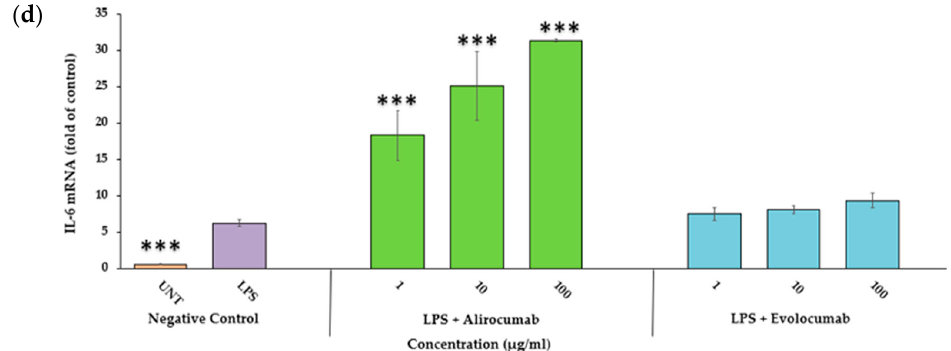
Figure 3. Effects of PCSK9 inhibitors on ( a ) PCSK9, ( b ) ICAM-1, ( c ) E-Selectin, ( d ) IL-6 gene expression in LPS-stimulated HCAEC. Data are expressed as mean ± SD (n = 9). Statistical analysis: ANOVA, post-hoc with Bonferroni correction; * p < 0.05, ** p < 0.01, and *** p < 0.001 compared to HCAEC incubated with LPS alone. Abbreviation: UNT (Untreated), LPS (Lipopolysaccharide). 2.6. Effects of PCSK9 Inhibitor on Endothelial Activation Gene Expression (ICAM-1 and E-